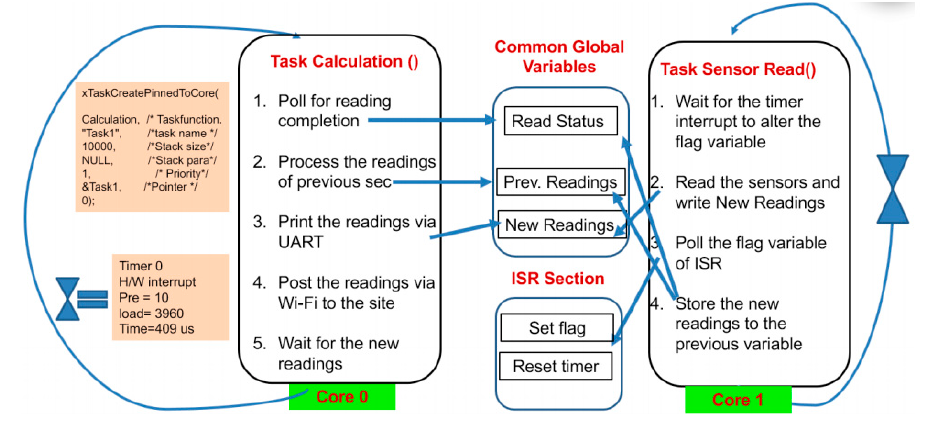
Figure 5. Task execution loops for both cores.